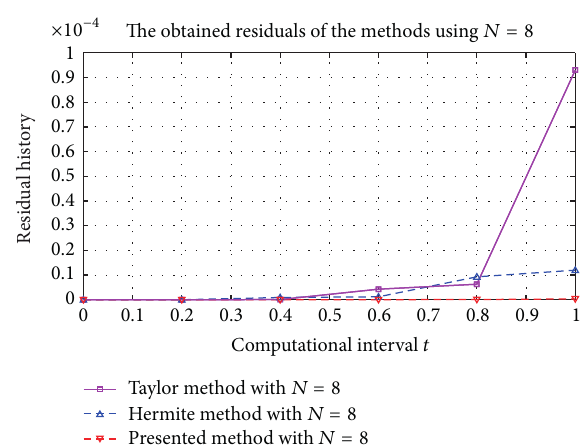
Figure 1: Comparison of the residuals of Taylor [3], Hermite [4], and presented methods of Example 5 for 𝑁 = 8